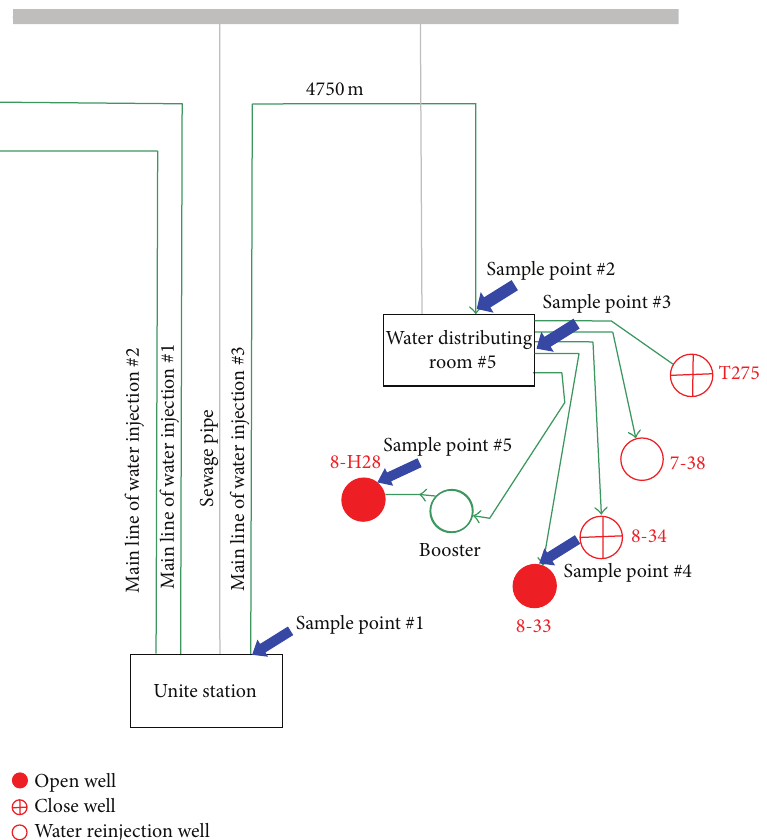
Figure 1: Schematic diagram of water and scale sampling